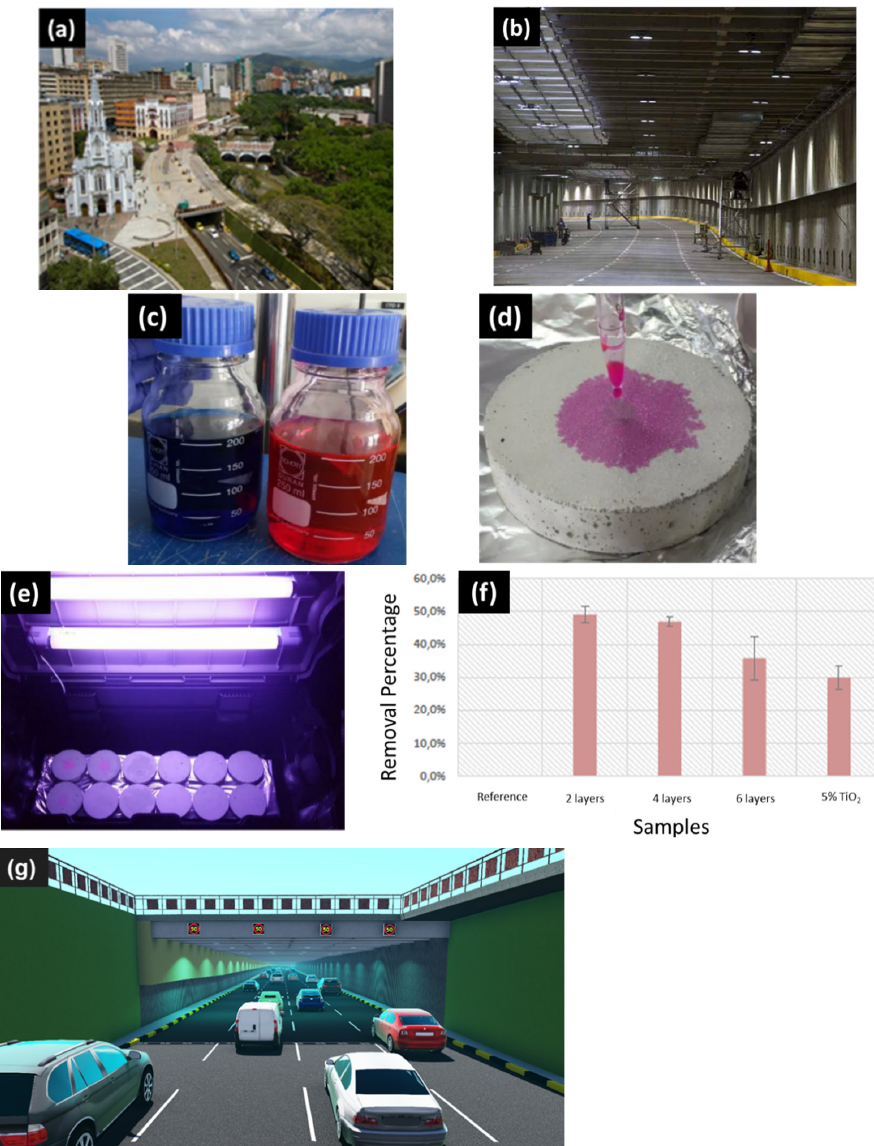
Figure 6. Preliminary evaluation of a photocatalytic coating and a mortar with 5%TiO 2 (related to the cement content) for application on the tunnel of the Colombia Avenue in the city of Santiago de Cali, Colombia. ( a , b ) Location and geometry of the Tunnel, ( c , d ) application of methylene blue and rhodamine B as dyes, ( e , f ) UV ‐ A exposure cabinet and dye removal results, ( g ) street canyon model variables for the winOSPM Software [55].